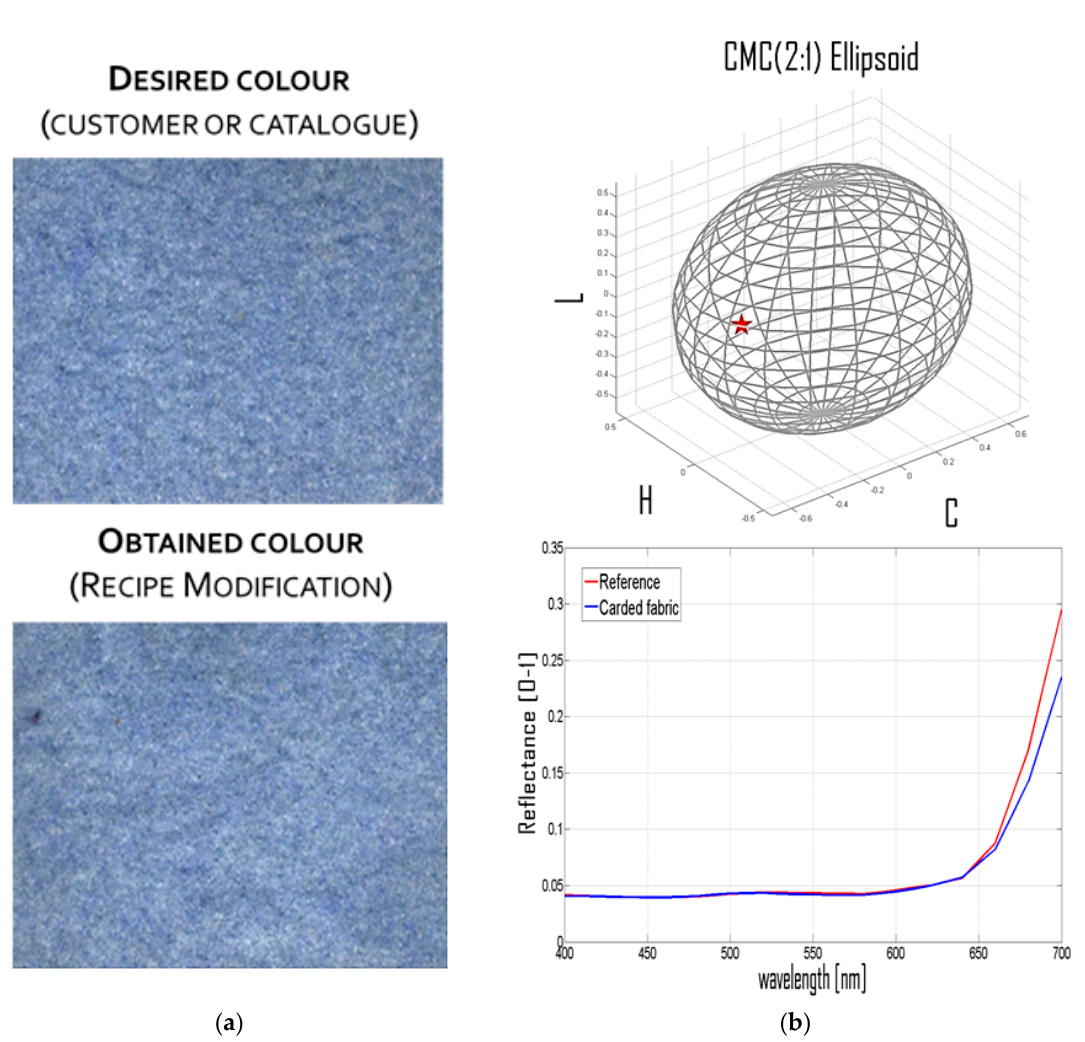
Figure 10. ( a ) Visual comparison between the color of desired and manufactured fabrics; and ( b ) CMC(2:1) Ellipsoid, spectrum R c ( λ ) and spectrum R r ( λ )